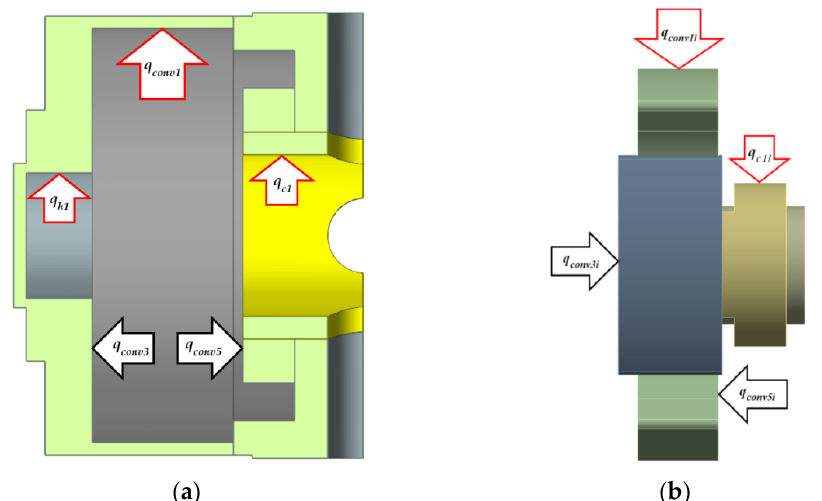
Figure 7. The heat flows in the left cap: ( a ) on the cap ’ s inner surface; ( b ) on the inner cylinder.